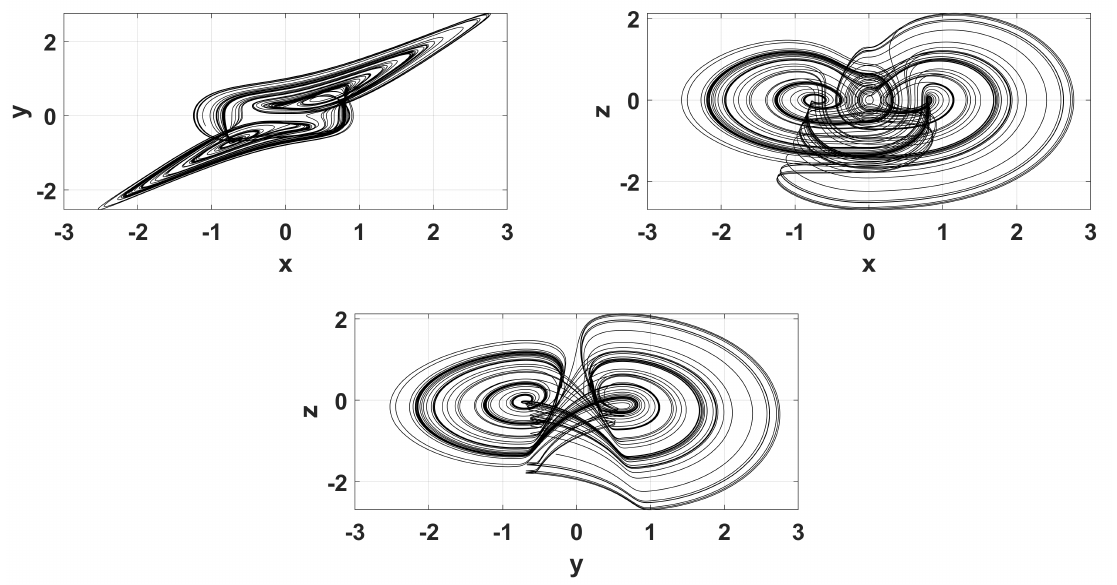
Figure 1. Phase portraits of system (1), for a = 0.65 and b = 0.1 and x ( 0 ) = ( 0,0.1,0.1 ) , for 1500 s.